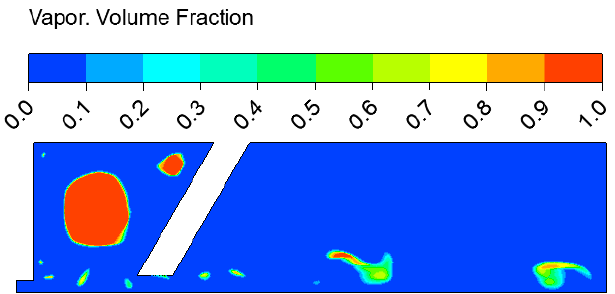
Figure 8. Vapour volume fractions in the SOC.